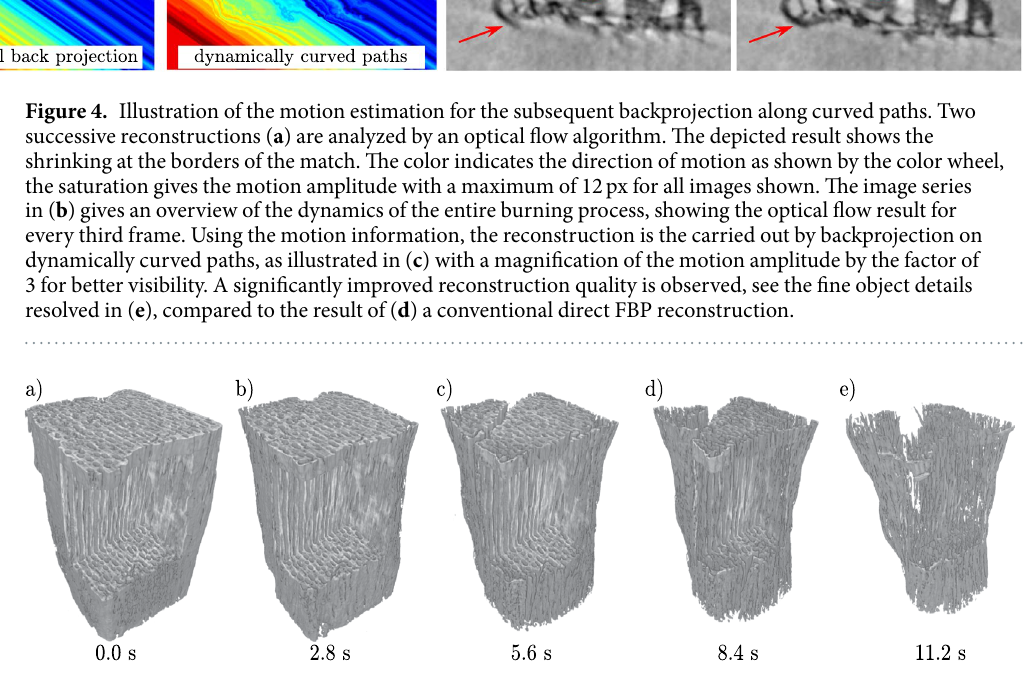
magnitude which the object underwent during the recording of 180°. Hence, the detected motion magnitude can be used directly without rescaling for the subsequent application of filtered backprojection on dynamically curved paths, which is used to ‘sharpen’ the reconstruction of the second set of projections to the given point in time. Figure 4(c) shows an exemplary backprojection with the deformation enlarged by a factor of 10 for better visibility. With this approach, the motion artefacts were significantly suppressed, and the reconstruction quality was significantly improved, compare for example the slices shown in Fig. 4(d) (without correction) and (e) (with correction). Both images depict an enlarged region of the object, reconstructed from the same projections. The direct reconstruction in (d) shows artefacts especially at the outer border of the match including non-closed dis- rupted structures and clearly visible streaks. In the motion based reconstruction, these artefacts are considerably reduced. New details in the wooden structure become visible as indicated. At this point, the entire process of motion estimation and correction can be iterated with the higher quality reconstructions. However, for the match presented here, a single iteration appeared to be sufficient. Based on the proposed dynamic backprojection approach, the dynamics of the burning process can now be investigated with high image quality and at high spatial and temporal resolution. The 4d nature and amount of analyzable data is illustrated in Fig. 5, showing the rendered 3d structure at 5 different times of the process. A high